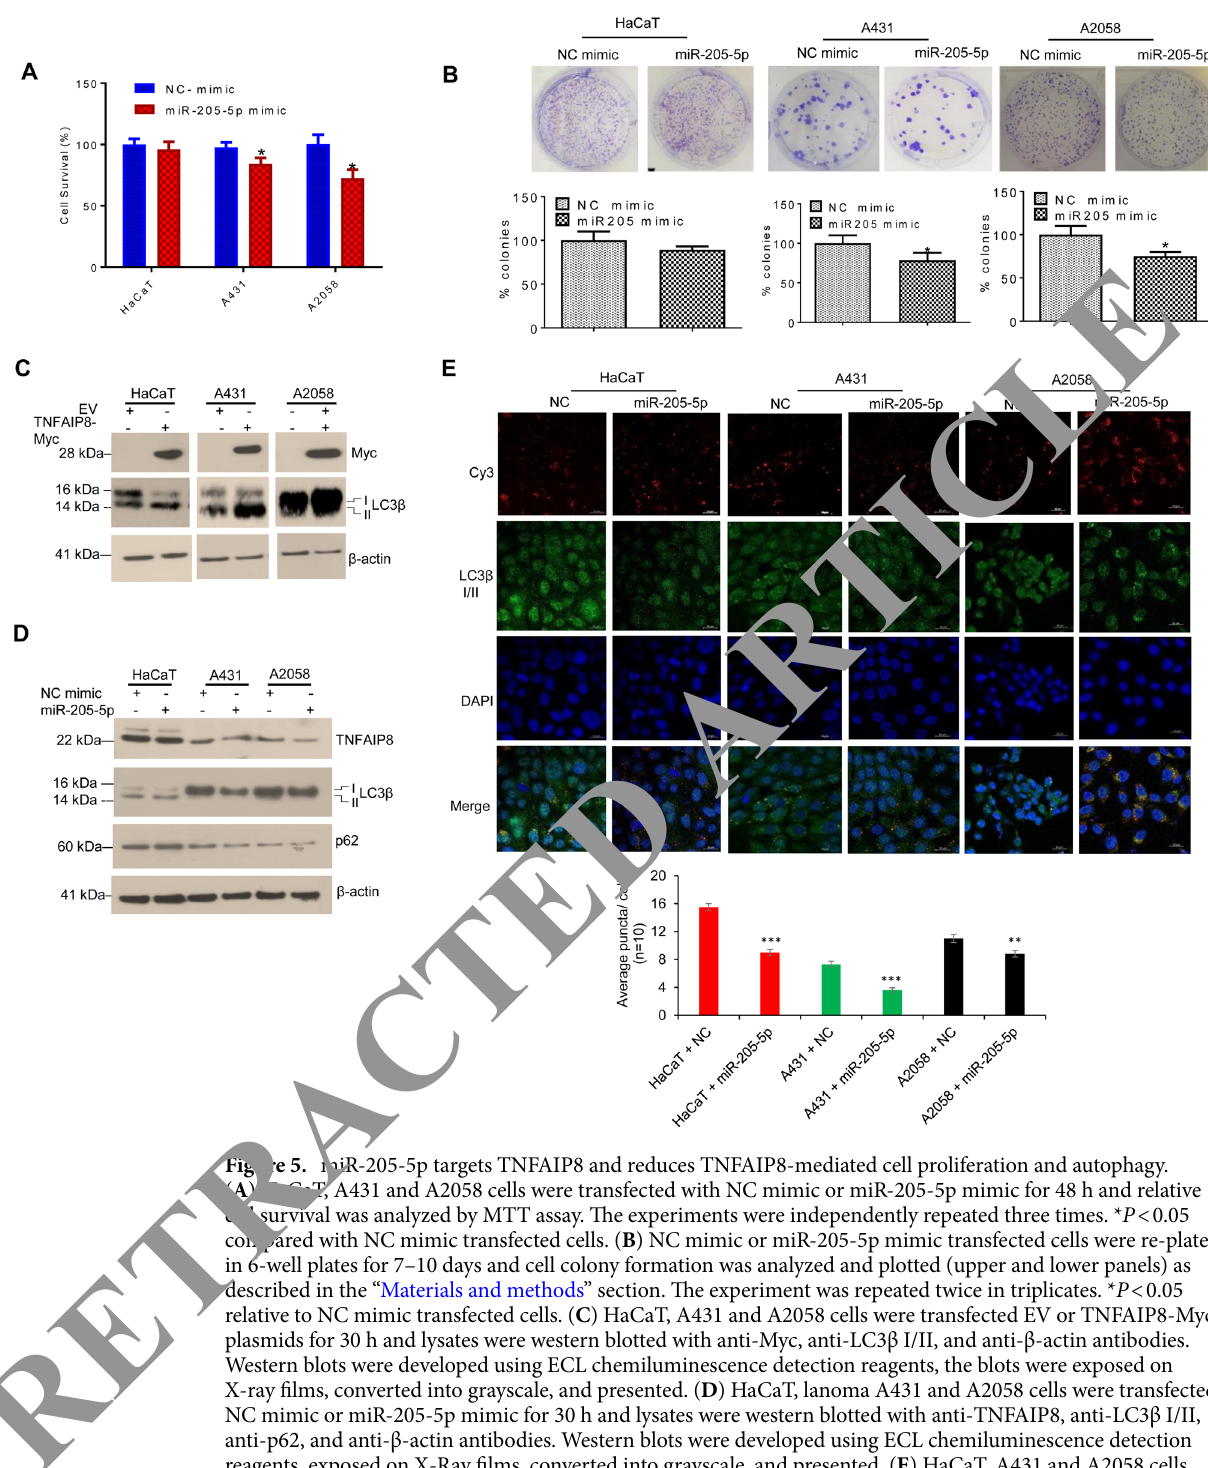
Figure 5. miR-205-5p targets TNFAIP8 and reduces TNFAIP8-mediated cell proliferation and autophagy. ( A ) HaCaT, A431 and A2058 cells were transfected with NC mimic or miR-205-5p mimic for 48 h and relative cell survival was analyzed by MTT assay. The experiments were independently repeated three times. * P < 0.05 compared with NC mimic transfected cells. ( B ) NC mimic or miR-205-5p mimic transfected cells were re-plated in 6-well plates for 7–10 days and cell colony formation was analyzed and plotted (upper and lower panels) as described in the “Materials and methods” section. The experiment was repeated twice in triplicates. * P < 0.05 relative to NC mimic transfected cells. ( C ) HaCaT, A431 and A2058 cells were transfected EV or TNFAIP8-Myc plasmids for 30 h and lysates were western blotted with anti-Myc, anti-LC3β I/II, and anti-β-actin antibodies. Western blots were developed using ECL chemiluminescence detection reagents, the blots were exposed on X-ray films, converted into grayscale, and presented. ( D ) HaCaT, lanoma A431 and A2058 cells were transfected NC mimic or miR-205-5p mimic for 30 h and lysates were western blotted with anti-TNFAIP8, anti-LC3β I/II, anti-p62, and anti-β-actin antibodies. Western blots were developed using ECL chemiluminescence detection reagents, exposed on X-Ray films, converted into grayscale, and presented. ( E ) HaCaT, A431 and A2058 cells were grown on a coverslip transfected with Cy3-labeled NC mimic or Cy3-labeled miR-205-5p mimic and the effect of Cy3-labeled miR-205-5p mimic on endogenous LC3β I/II expression (green) and related puncta formation were visualized by immunofluorescence (upper panels) as described in the “Materials and methods” section (upper panel). LC3β I/II and related puncta were measured from individual cells (n = 10) and plotted (lower panels). ** P < 0.01, *** P < 0.001 relatives to Cy3 labeled-NC mimic transfected